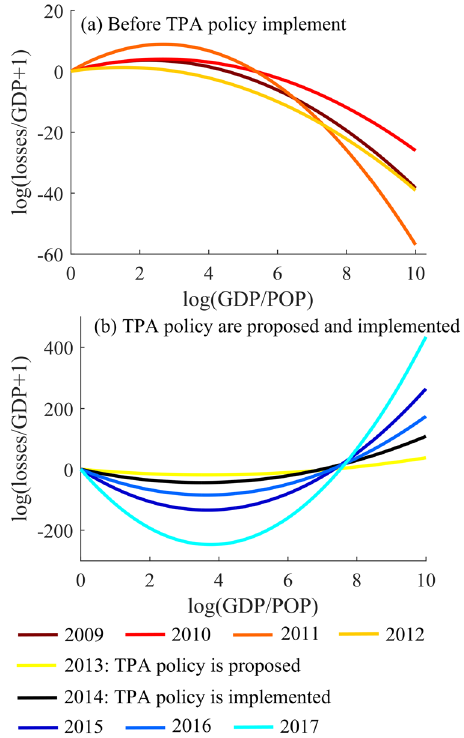
Fig. 4 Nonlinear relationships between losses from geological disasters and economic development level between 2009 and 2017 in Yunnan Province. The coef fi cients of log(GDP it /POP it ) and [log(GDP it /POP it )] 2 are derived from negative binomial regressions in Table 1. a Inverted U-shaped relationships are obtained for the years 2009 – 2012. b U-shaped relationships are obtained for the years 2013 –